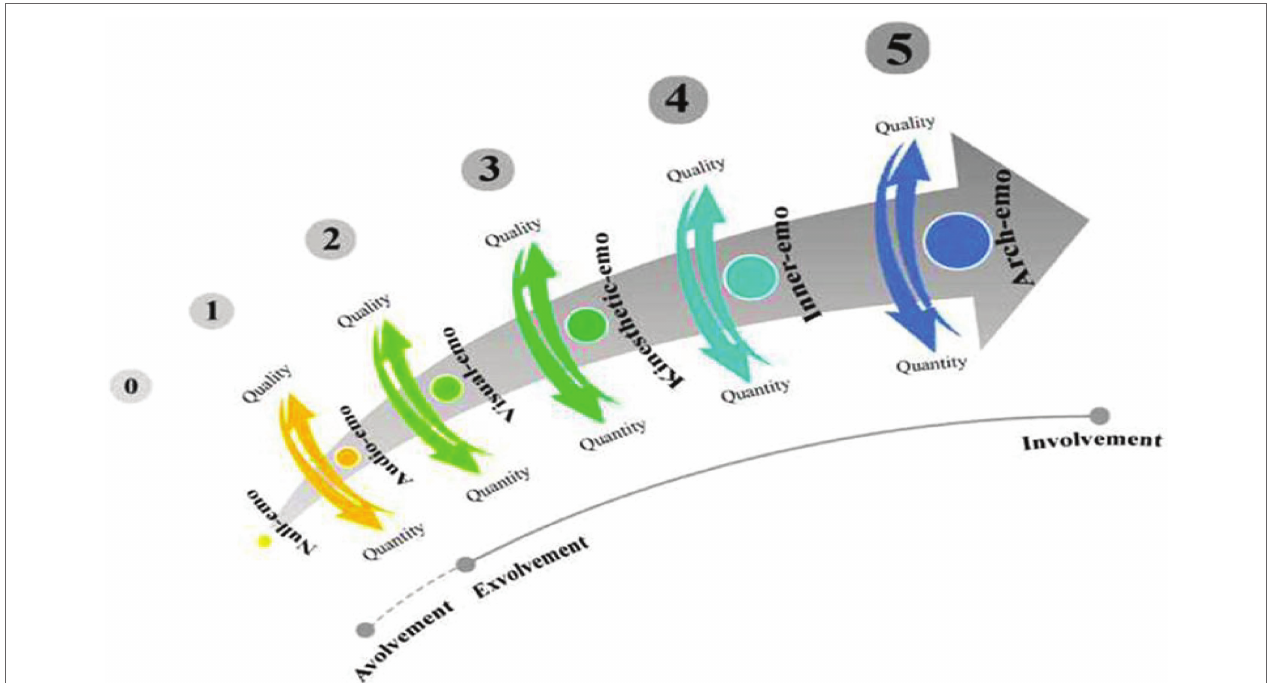
FIGURE 1 | Emotioncy matrix. Adapted from Pishghadam (2015, p.